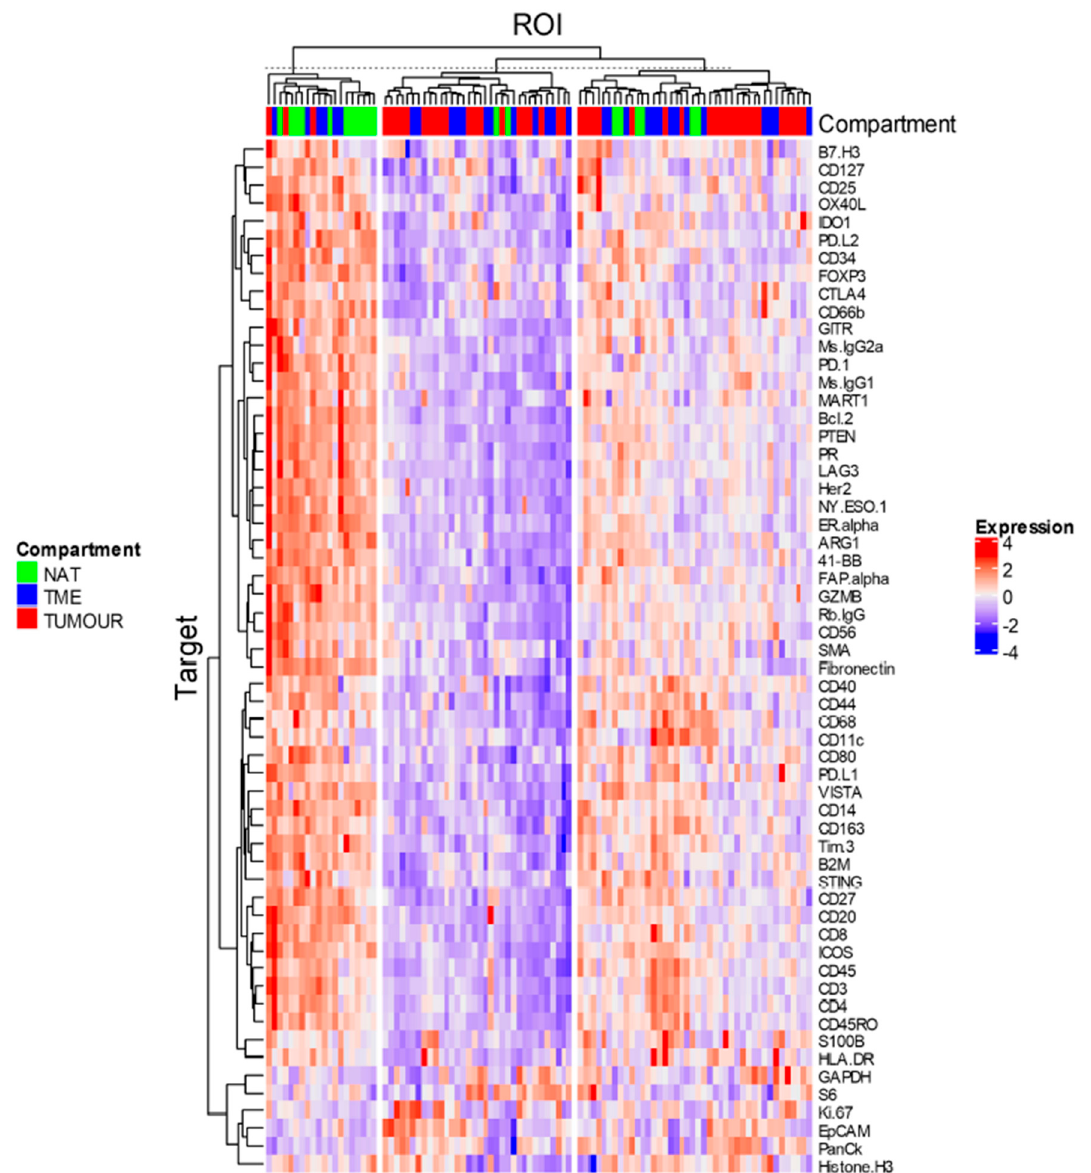
Figure 6. Clustered heatmap of relative expression of proteins per ROI. Ward D2 clustering was applied, followed by K -means clustering to delineate differences between expression profiles among compartments. NAT: normal adjacent tissue; TME: tumour microenvironment; tumour: tumour region. Global correlation matrices for target protein expression within the TME (Figure S3) and tumour (Figure S4) indicated a large number of significant ( p ≤ 0.001) positive